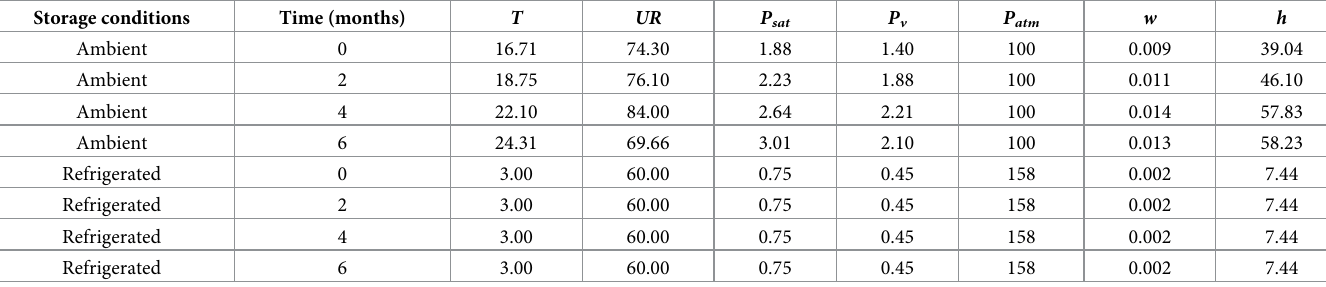
Table 2. Characterization of ambient air and intergranular chilled air in the storage of soybean seeds. Storage conditions